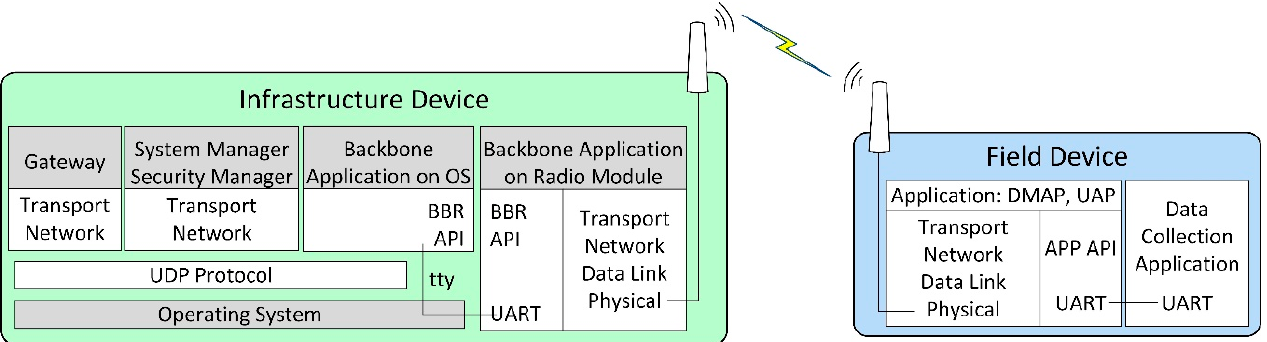
Figure 2. The internal architecture of physical ISA100 IWSN